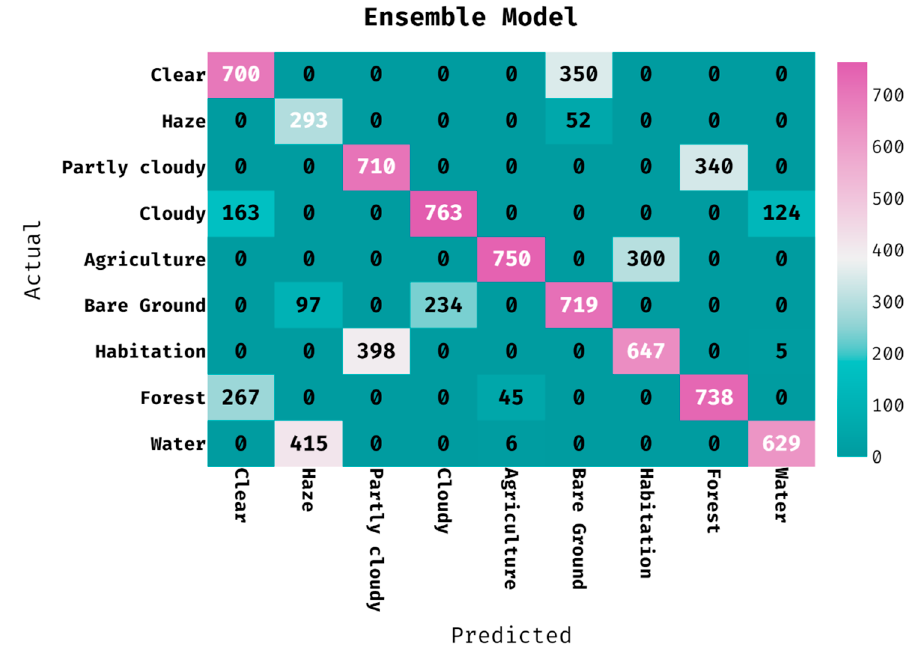
Figure 9. Confusion matrix of ensemble model with different classes.